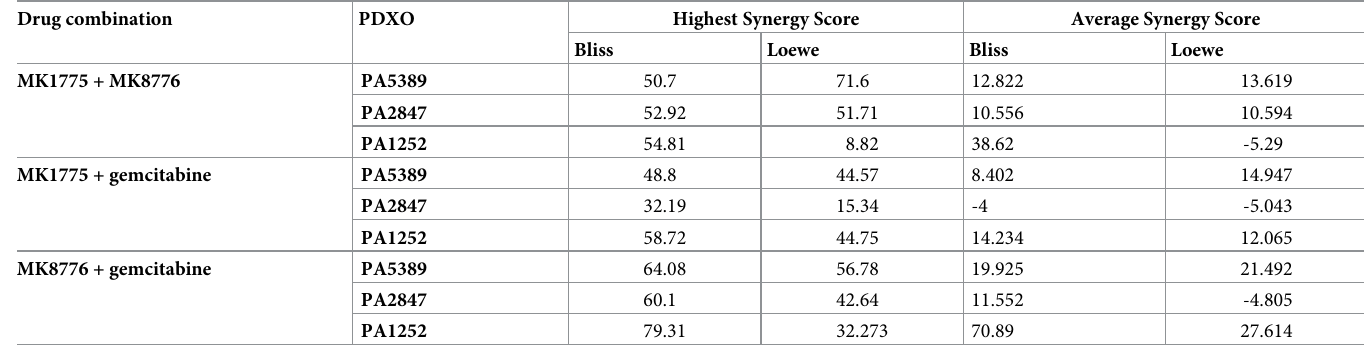
Table 1. Summary of synergy of combination drug treatments in pancreatic PDXOs. Drug